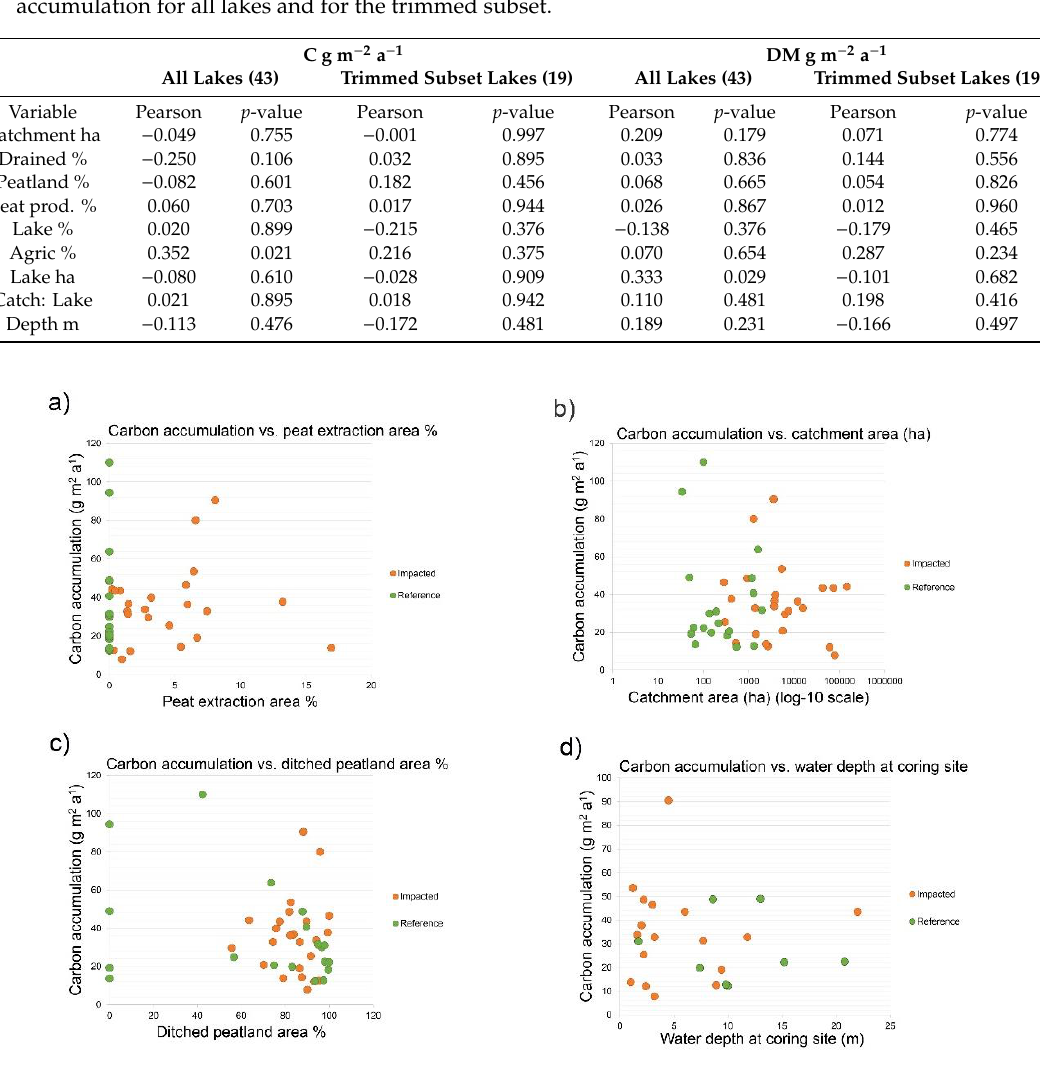
Figure 8. Carbon accumulation rates for the post-1986 period (g m −2 a −1 ) compared to four environmental variables, with ( a ) peat extraction area (%), ( b ) catchment area (ha), ( c ) ditched peatland area (%), and ( d ) water depth at coring site.